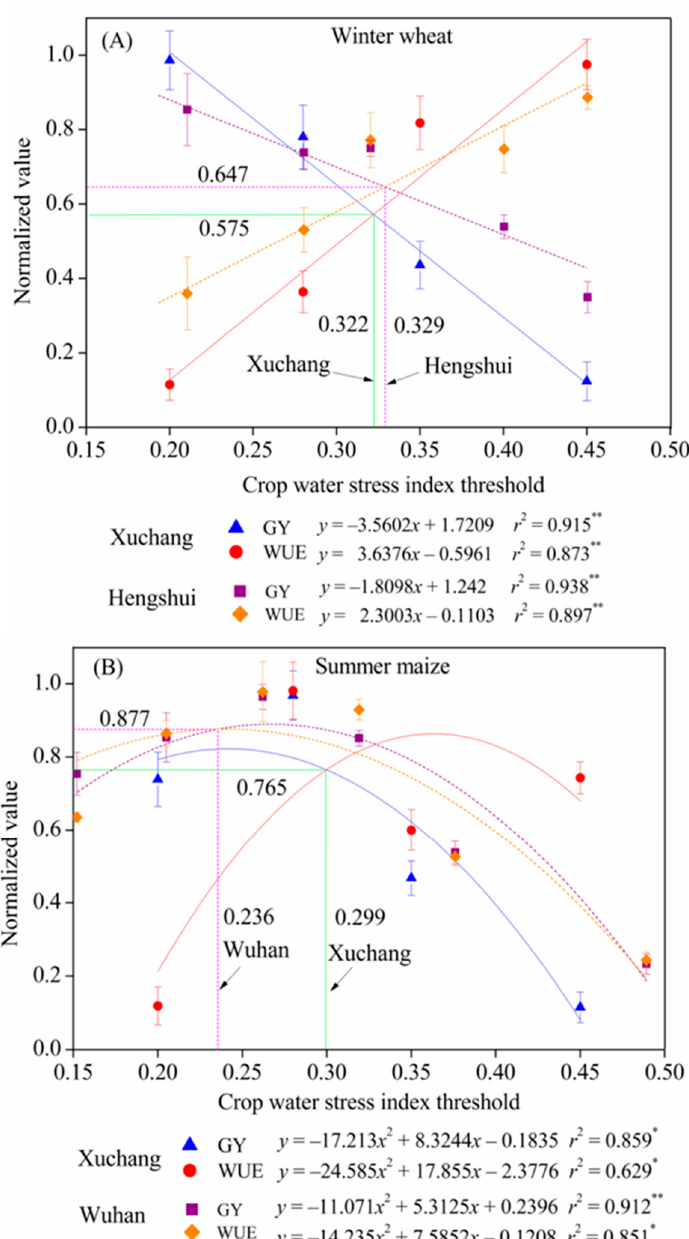
Figure 8. The relationship between grain yield (GY, y )/water use efficiency (WUE, y ) and crop water stress index threshold (CWSI, x ) for ( A ) winter wheat and ( B ) summer maize based on field experiments conducted at the Xuchang Irrigation Experiment Station in the 2019–2020 growing season. Data from Hengshui [68] and Wuhan [69] were adopted to compare the CWSI thresholds for winter wheat and summer maize from Xuchang. Date were reconstructed and reproduced with the permission from Zhao Y., Master’s Degree Dissertation; published by Chinese Academy of Agricultural Sciences, Beijing, China, 2016; and Wang S., Master’s Degree Dissertation; published by Huazhong Agricultural University, Wuhan, China, 2008. GY and WUE values were normalized before use. Vertical error bars indicate standard deviation (SD). * and ** mean significant correlation at p < 0.05 and p < 0.01, respectively. Adapted with permission from Ref. [68]. 2016, Zhao Y. Adapted with permission from Ref. [69]. 2008, Wang